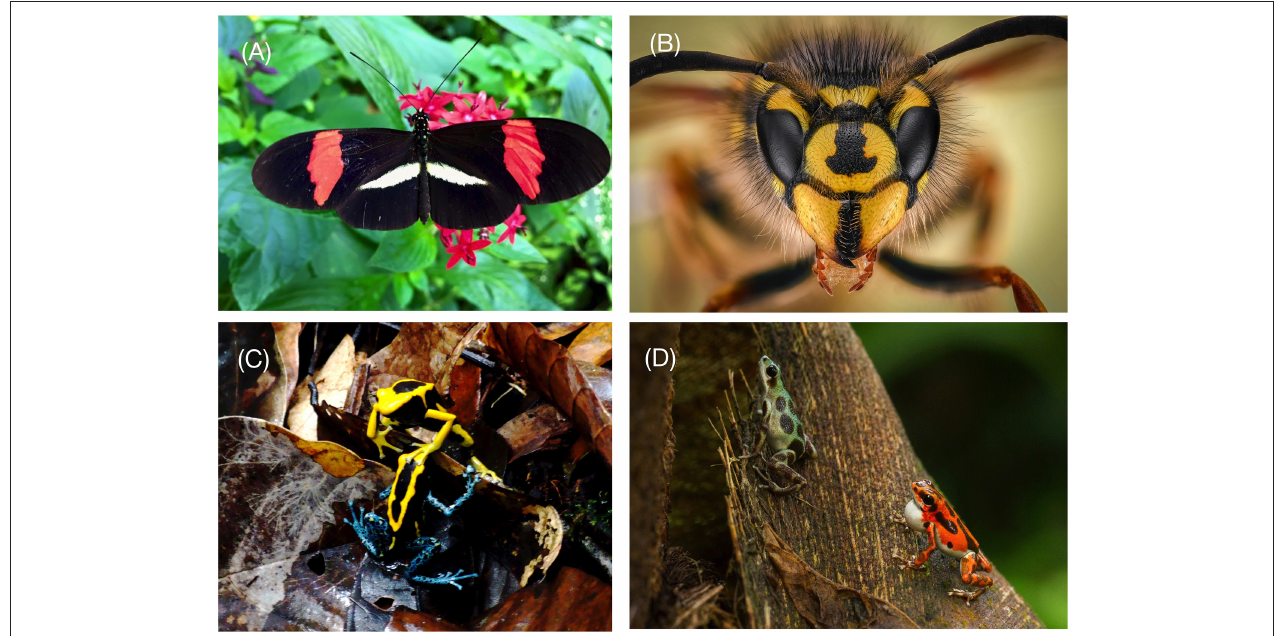
FIGURE 4 | In some aposematic species warning signals are also used for intraspecific communication. (A) In the postman butterfly, Heliconius erato , wing color pattern can serve a dual purpose in predator deterrence and mate attraction; (B) Some wasps can use their facial yellow-and-black markings for individual recognition and status signaling; (C) Males of the dyeing poison frog ( Dendrobates tinctorius ) tend to have yellower dorsal areas, possibly to enhance protection from predators during tadpole transport, while females with higher amounts of yellow in their frontal area are more often found in courtship; (D) In some populations of the strawberry poison frog ( Oophaga pumilio ), brighter males are preferred by females and also have a higher status in agonistic encounters with other males. Photos: (A) S. Finkbeiner; (B) E. Florin Niga; (C) B. Rojas; (D) A.